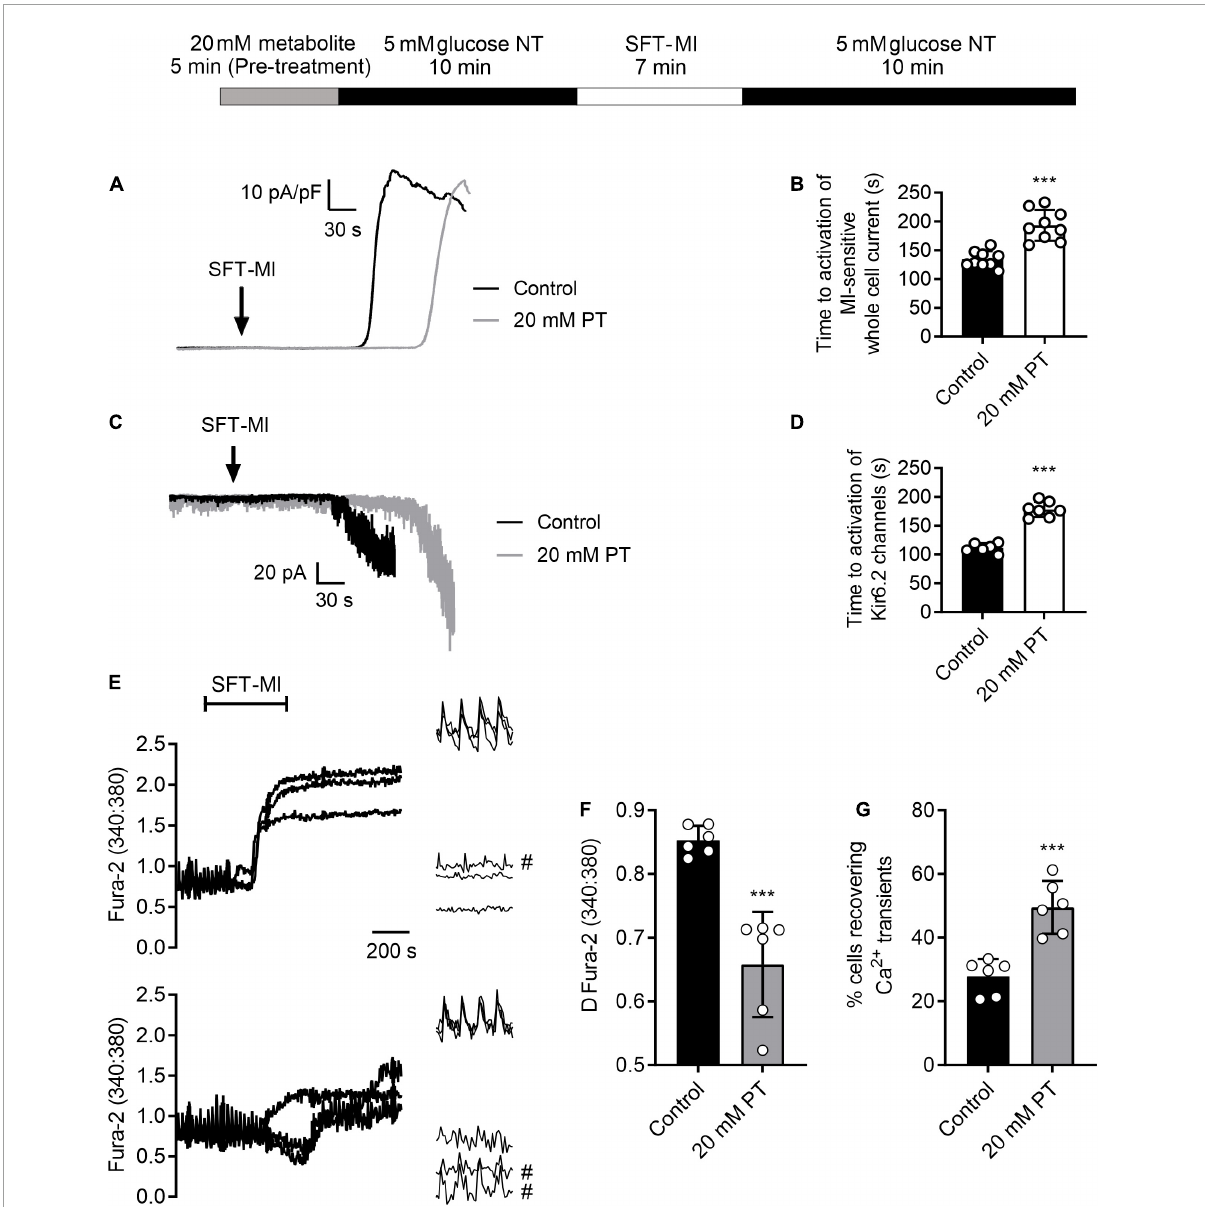
FIGURE2 High glucose pre-treatment delays activation of the metabolic inhibition-sensitive K ATP current and limits calcium overload during metabolic inhibition. (A) Example traces of whole-cell current recorded at 0 mV showing the activation of a metabolically-sensitive outward K + current. (B) Bar chart showing the mean time to activation of this metabolic inhibition-sensitive current in control conditions (perfused for 15 min with NT prior to SFT-MI) or with 5 min high glucose pre-treatment. Mean time to activation was significantly delayed following 20 mM PT [*** P > 0.001, Unpaired T -test, n = 9 ( > 14) for each group]. (C) Example traces of cell attached recording of sarcolemmal Kir6.2/SUR2A (IK ATP ) current activation by metabolic inhibition, identified by its single channel conductance. (D) Bar chart showing the mean time to activation of Kir6.2/SUR2A channels with a burst duration longer than 250 ms. [*** P > 0.001, Unpaired T -test, n = > 6 ( > 10) for each group]. (E) Example traces and expanded transients, recorded at the beginning and end of the protocol, from three cells in control conditions (perfused for 15 mins prior to SFT-MI with NT solution) and three cells in a 20 mM glucose pre-treated group (perfused for 5 min with 20 mM glucose NT followed by 10 min washout with NT). Cells recovering transients are marked with #. Cardiomyocytes were stimulated to contract using 1 Hz EFS and perfused at 34 ± 2 ◦ C. Fura-2 ratio images were taken once every 5 s to minimise photo bleaching. Transients were recorded at a rate of 12 ratios per second (24 images). (F) The mean change in Fura-2 ratio at the end of the 10 min simulated reperfusion period showing a reduction in Ca 2 + accumulation in the 20 mM glucose pre-treated group compared to control conditions [*** P < 0.001, unpaired T -test, n = 6 ( > 84 cells) per group]. (G) Mean percentage of cells recovering Ca 2 + transients at the end of the simulated reperfusion period showing an